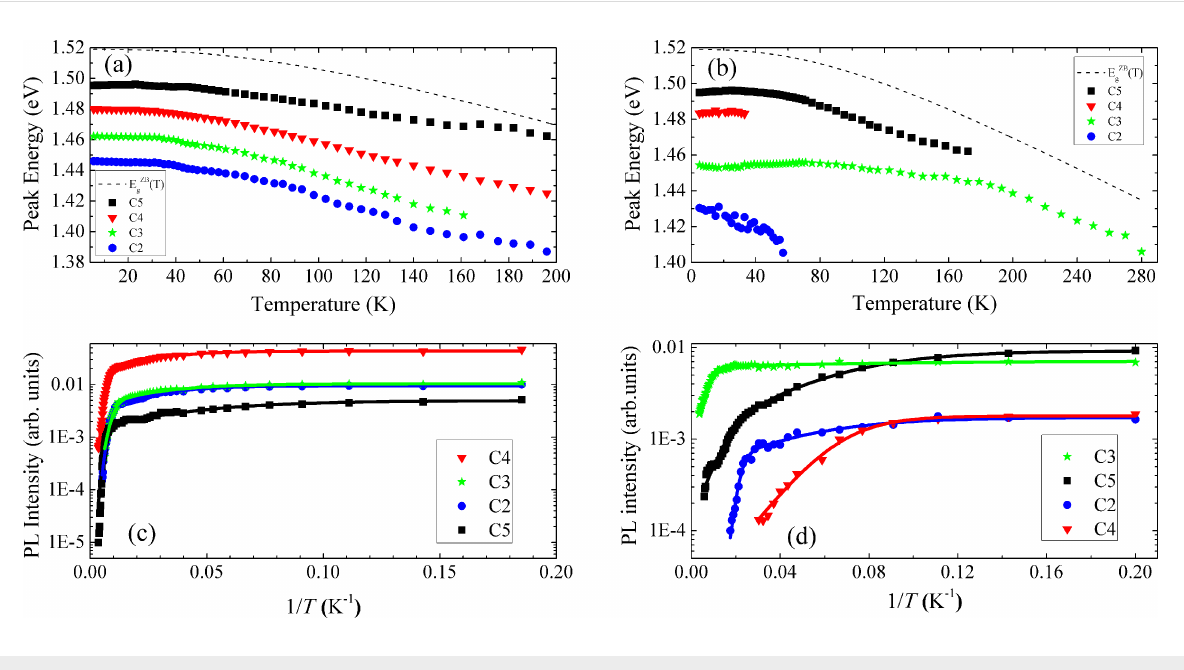
Figure 7: Dependence on the temperature of the peak energy for (a) sample A and (b) sample B, and of the PL intensity for (c) sample A and (d) sample B. The dashed lines in (a) and (b) represent the dependence on the temperature of (Equation 5), using the parameters of Pässler for the ZB crystalline phase of GaAs [63]: E g (0) = 1.51909 eV, α = 0.4730 meVK − 1 , Θ = 225.6 K, q = 2.513. The lines in (c) and (d) are the fits of Equation 6 to the experimental points whose values are listed in Table